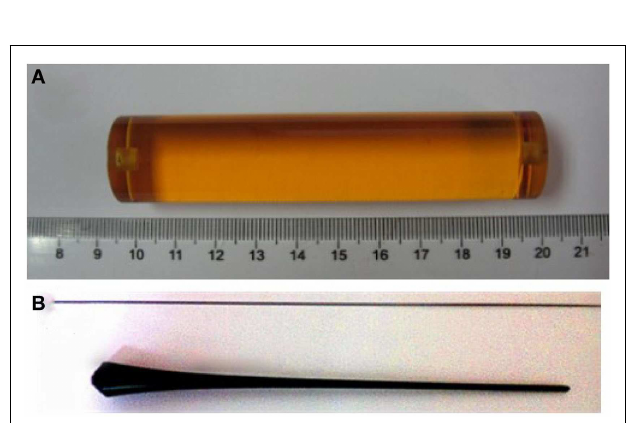
FIGURE 22 | Digital photographs of (A) the as-prepared glass preform and the obtained fiber . (B,C) TEM images of PbS nanocrystals formed during fiber-drawing process (Bhardwaj et al., 2012).